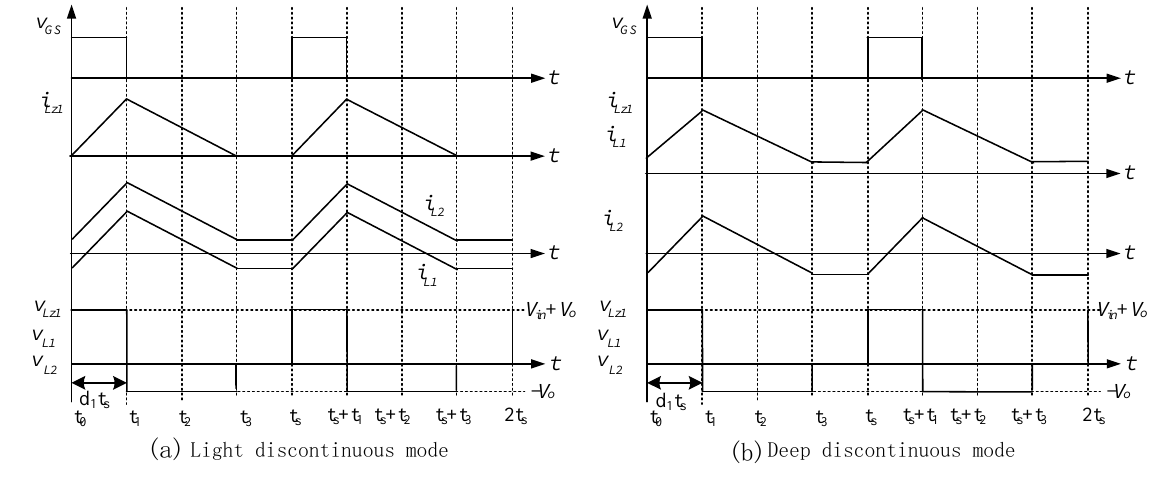
Figure 4. Theoretical waveforms of the proposed converter in DCM.